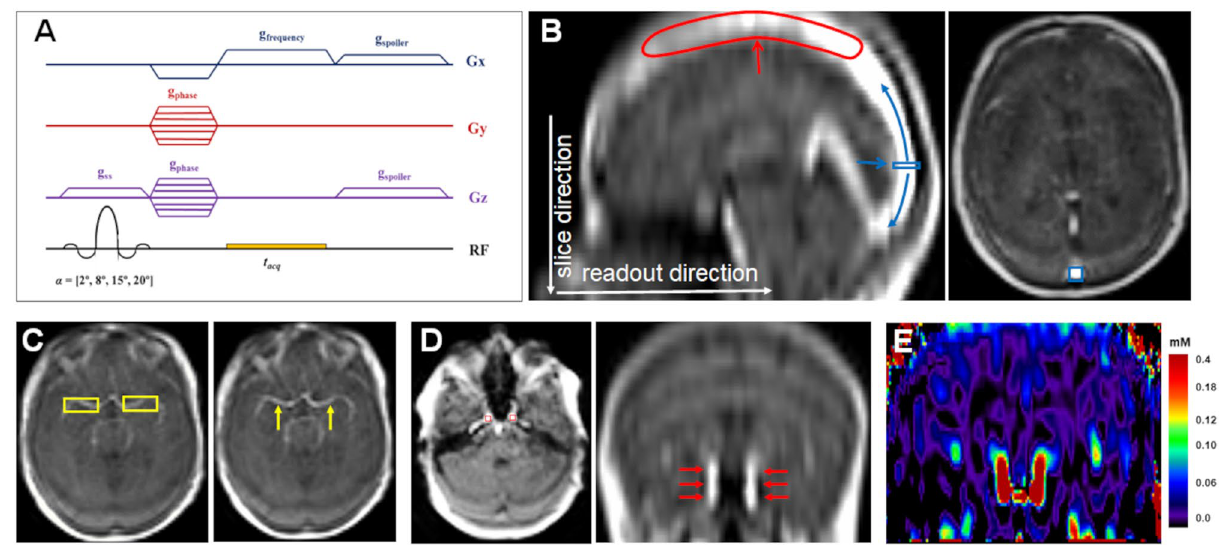
Figure 1. Magnitude-based input function extraction. ( A ): Pulse sequence diagram of 3D spoiled gradient recalled echo (GRE) sequence used for the variable flip angle (VFA) and low-dose high temporal resolution (LDHT) DCE-MRI acquisition, with axial slab orientation and anterior–posterior frequency encoding. Acquisition parameters: flip angle/s of 2, 8, 15, 20°; TR/TE of 2.5 ms/0.696 ms; SENSE acceleration factor of 1.8, reconstructed matrix size of 96 × 96 × 22, voxel size of 2.5 × 2.5 × 6.35 mm 3 , pixel bandwidth of 700 Hz, and frame duration (Δt) 1.0 s (n = 300). Pulse of frequency encoding/readout gradient (g frequency ), phase encoding gradient (g phase ) and slice select gradient (g ss ) are shown along with signal acquisition time (t acq ). Gradient spoilers (g spoiler ) were applied along both the read and slice/slab selection directions and phase cycling with a phase increment angle of 117° was also used, allowing for more complete dephasing of residual transverse magnetization, and minimizing blood inflow-induced errors within each imaging slice. ( B ): Sagittal ( left panel ) and axial ( right panel ) signal-intensity (SI) images of a postcontrast time frame from the LDHT DCE-MRI series for a representative patient. Sagittal view shows that the anterior-middle portion of the SSS (red arrow) is included in the FOV of the 3D acquisition. This maximizes the number of RF pulses that the flowing blood experiences before it reaches the posterior portion of the SSS, helping to reduce blood inflow-induced errors. Following manual delineation of a small rectangle ROI within the vertical/posterior SSS ( blue arrow ), an automatic extraction method is used to identify voxels within neighbouring axial slices of the posterior SSS ( blue arrows ) that display maximum enhancement area under the SI curve within 30 s of the bolus arrival time (AUC 30 ). A mean SI-time curve is then calculated from 20 voxels with the highest AUC 30 and converted to a plasma GBCA concentration–time curve C p (t) using a literature value of blood R1 0 of 0.694 s -1 . ( C ): Axial SI images of a postcontrast LDHT DCE time frame for the patient shown in panel A showing the site of MCA VIF delineation. A pair of rectangle ROIs was drawn covering the horizontal segment of the MCA bilaterally ( yellow rectangles, left panel ). Using the described automatic method neighbouring contiguous axial slices were searched to identify twenty voxels within the MCA bilaterally ( yellow arrows, right panel ) that displayed maximum AUC 30 . ( D ): Axial ( left panel ) and coronal ( right panel ) SI images of a postcontrast LDHT DCE time frame for the patient shown in panel A showing the site of ICA VIF delineation. A pair of rectangle ROIs were manually drawn on an axial image section over the ICA (just distal to the carotid syphon) bilaterally. An automatic method was then used to search and identify twenty voxels within neighbouring contiguous axial slices of the carotid syphons ( red arrows, right panel ) that displayed maximum AUC 30 . ( E ): Coronal GBCA concentration C(t) image (mM) derived from the difference image ((ΔS = S(t)−S(0)) between the pre- and post-contrast SI images shown above. Whilst observed ring-like artefacts are present in the coronal SI images shown above, such artefacts are not present in either the 4D GBCA concentration—time images (where the VIF/VOF are measured) shown, or pharmacokinetic parameter maps derived from these 4D concentration–time images. GBCA = Gadolinium- based contrast agent; ICA = Internal carotid artery; MCA = Middle cerebral artery; SSS = Superior sagittal t r e − ( t / b ) , where Q, r and b are constants. C p ( t ) = Q (cid:31) (cid:30) For each extracted VOF/VIF the following semi-quantitative parameters were derived and compared: the contrast-to-noise ratio (CNR), the bolus arrival time (BAT), the bolus peak-amplitude, the bolus peak width (FWHM, full-width at half-maximum) and the bolus peak∙FWHM product (PWP), a parameter associated with the area under the bolus curve. For measurement of VOF in the SSS, blood inflow-induced errors were reduced by including the anterior and middle third of the SSS in the field of view thereby maximizing the number of RF pulses that the flowing blood experiences before it reaches the posterior third of the SSS. Following manual delineation of a small rectangle ROI within the vertical/posterior SSS (Fig. 1B), an automatic extraction method was used to search and identify voxels within this segment of the SSS that display maximum enhancement area under the SI curve within 30 s